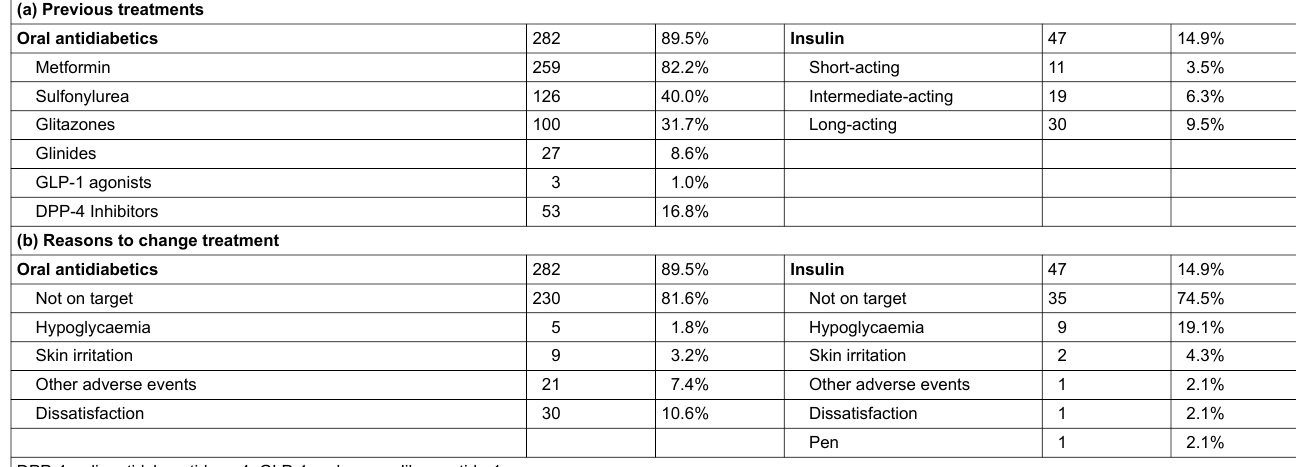
Table 2: Use of antidiabetic drugs prior to enrolment and reasons to change the antidiabetic treatment indicated at baseline visit. Figures represent the number and percent of patients in the intention to treat population (n = 315). (a) Previous